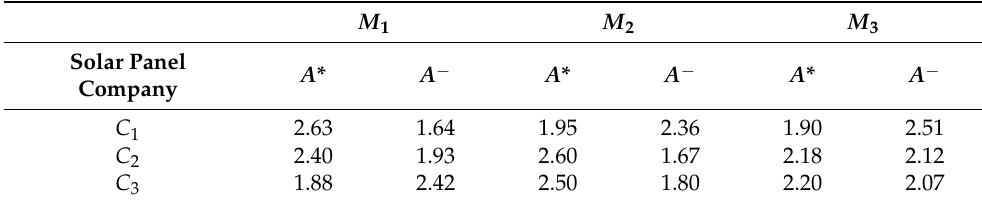
Table 18. Euclidean distance of each solar panel company for each manufacturing company.